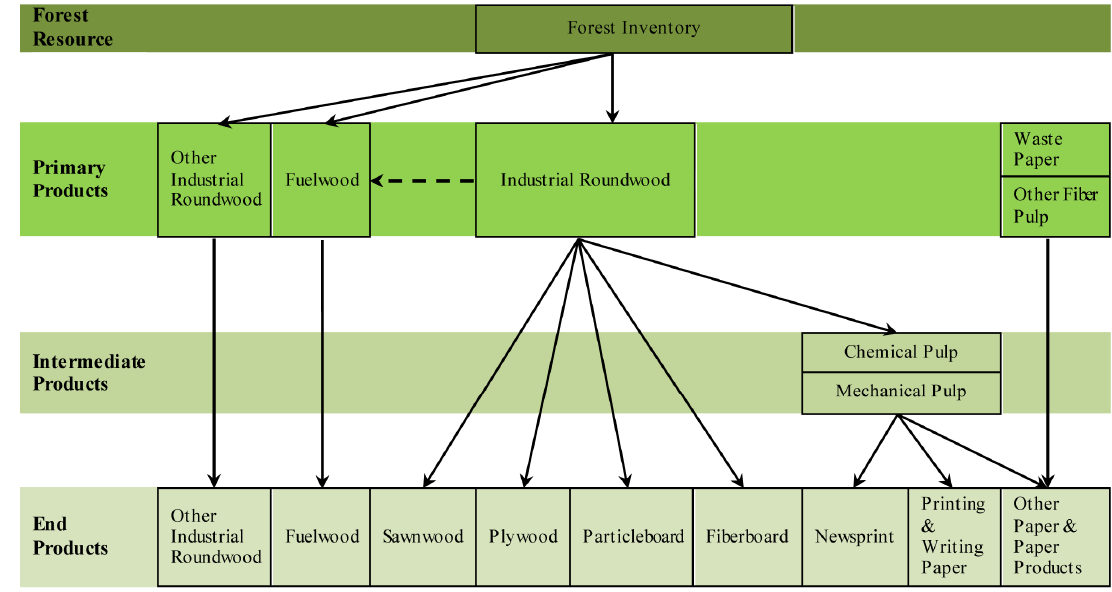
Figure 2. Processing chain of the 14 forest products in the global forest products model (GFPM) (adapted from Buongiorno et al. [29]).